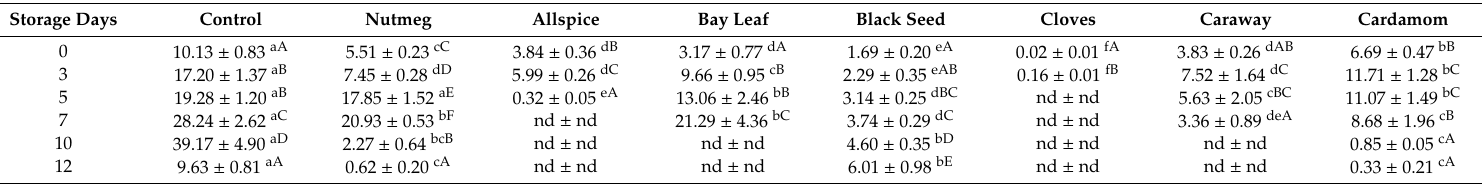
Table 3. E ff ect of various spice extract treatments on hexanal content (mg / 100 g meat) in raw ground chicken legs during 12 days of refrigerated storage (4 ◦